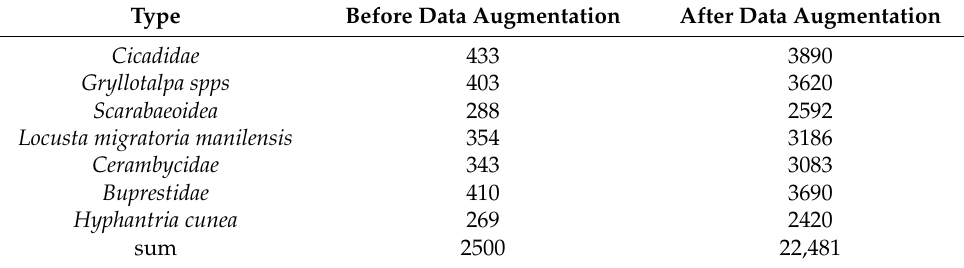
Table 1. Images from web crawler.